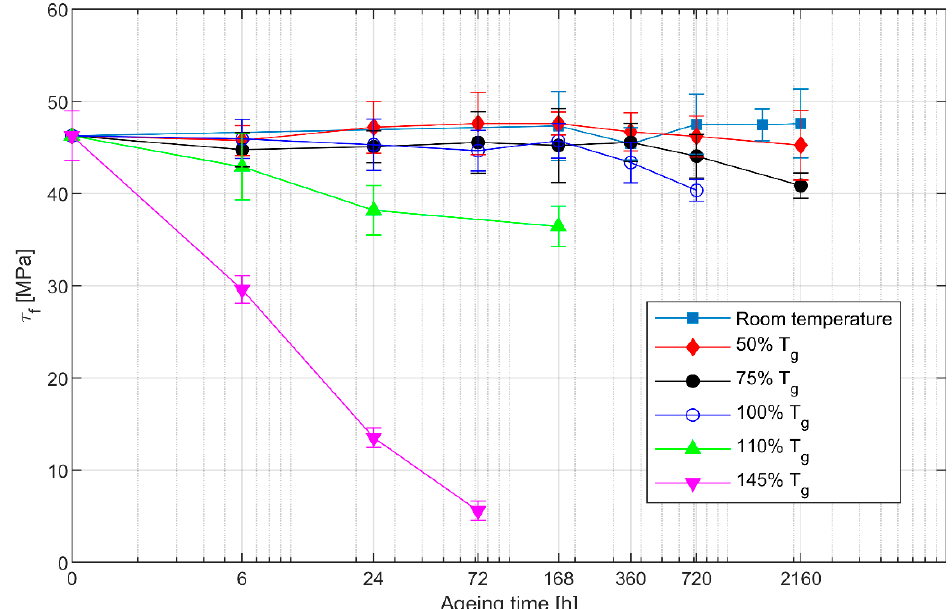
Figure 3. Interlaminar shear strength of the isothermally aged specimens. The logarithmic scale on the horizontal axis has been adjusted so that the leftmost point represents the specimens in the unaged condition.